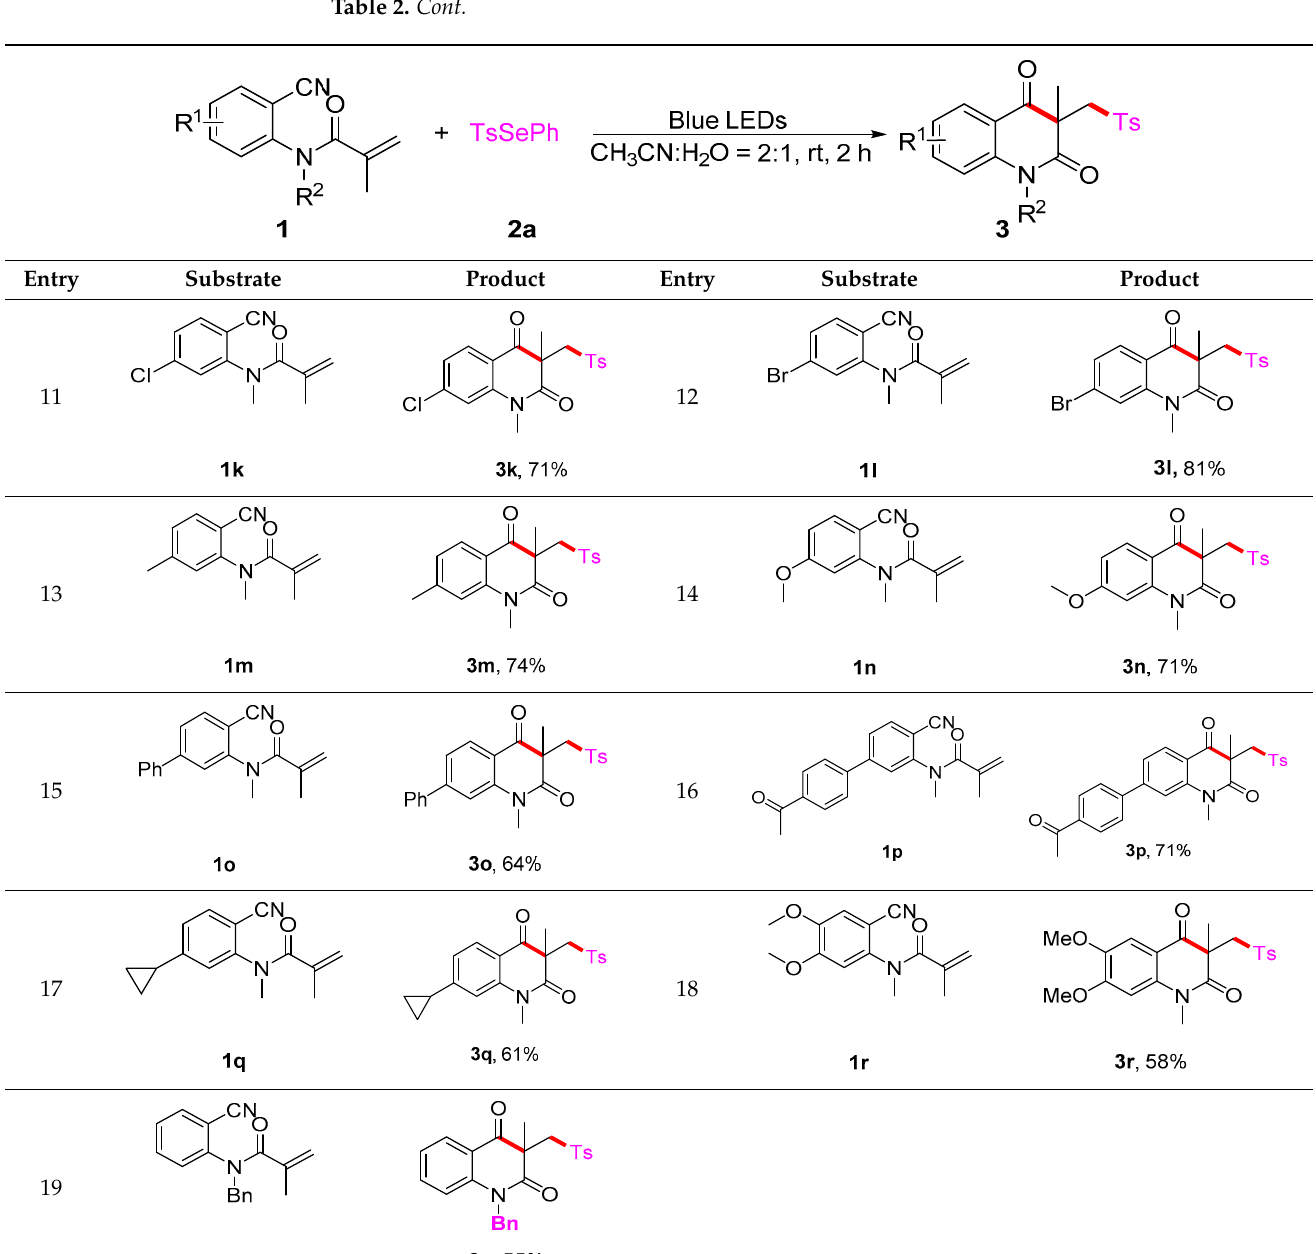
Table 2. Cont. Table 2. Substrate scope of 1 a , b .